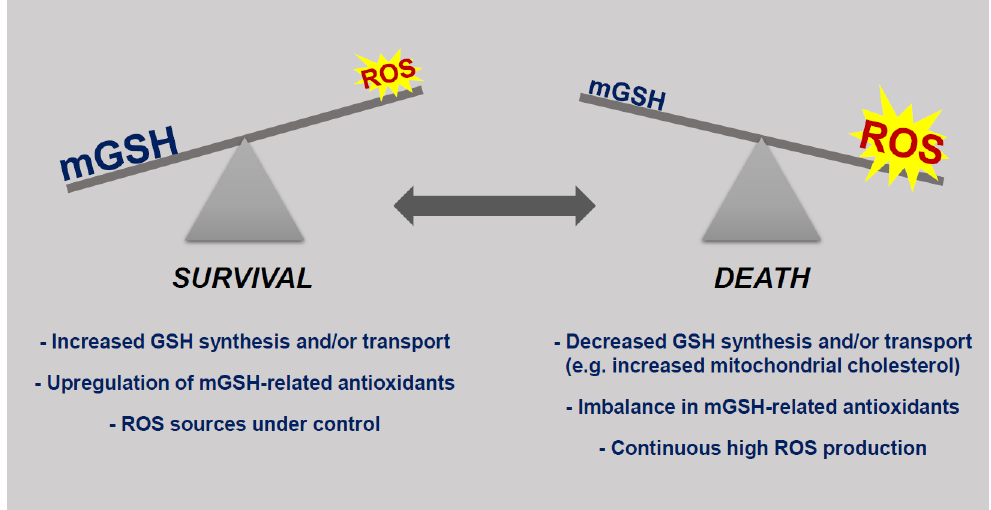
Figure 5. The balance between mGSH levels and reactive oxygen species (ROS) present in the mitochondrial milieu determines cellular susceptibility to death stimuli. Under physiological conditions or even in the continuous presence of increased ROS production survival is guaranteed due to upregulation of GSH-related antioxidant mechanisms. Mitochondrial death only arises when the production of ROS is high and/or the levels of mGSH are compromised due to minor synthetic capabilities or problems with mGSH